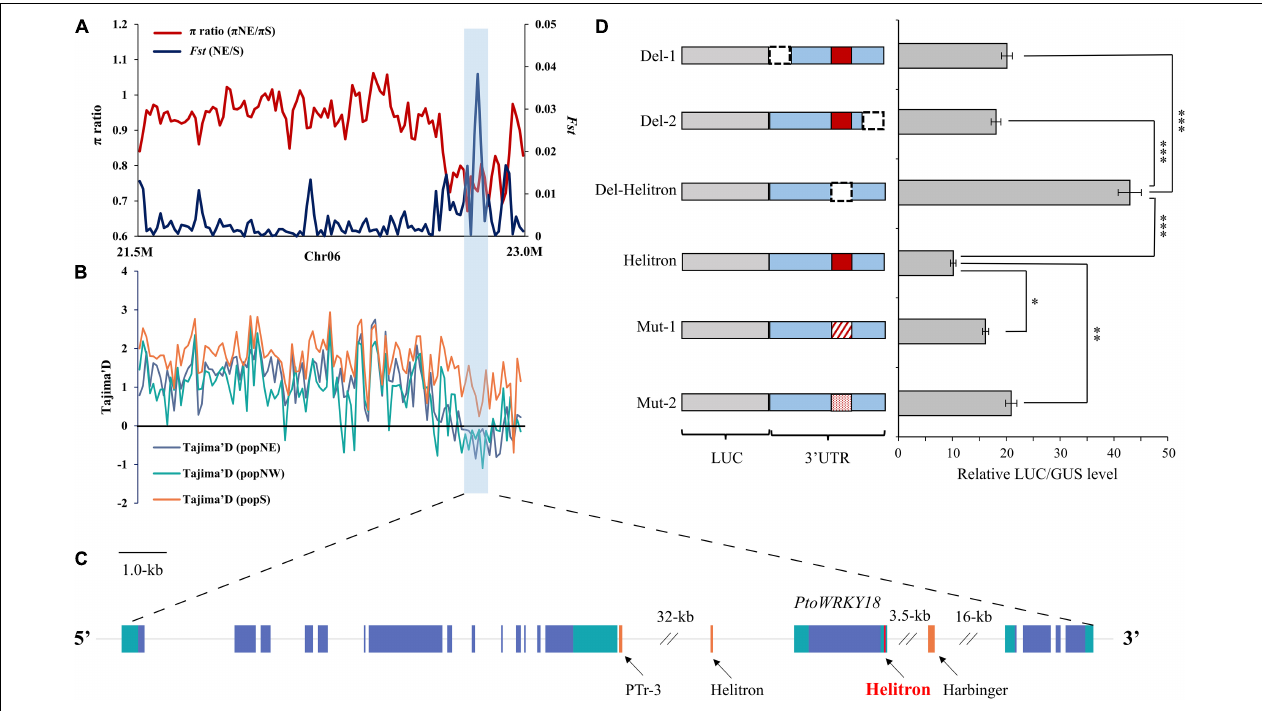
FIGURE 5 | An adaptive TE within selection regions among the three P. tomentosa natural climatic regions. (A–C) Adaptive TEs with a selection signal between each pairwise comparison. The values of F st , π , and Tajima’s D were plotted using a sliding window of 500-bp. Target population (Orange), and reference population (blue). The horizontal dotted line represents the corresponding average value in all selected scanning areas. Genes at the bottom (blue rectangle, coding sequences; black line, introns and intergenic regions; green rectangle, 5 (cid:48) and 3 (cid:48) untranslated regions; red rectangle, Helitron insertion TEs; orange rectangle, other TEs). (D) Left panel, firefly luciferase reporter constructs fusing the full-length WRKY18 3 (cid:48) -UTR (Helitron), deletion variants (Del-1, Del-2, and Del-Helitron), and substitute variants (Mut-1, and Mut-2). Luciferase gene was dark gray with diagonal; 3 (cid:48) UTR is blue, the deleted area is represented by dotted line, and the variant is represented by red line with diagonal and point; The red rectangle in the 3 (cid:48) UTR represents the Helitron transposon. Right panel, relative luminous units and transcription levels quantified by qPCR (Helitron normalized to 1). The data in the right panel represent the mean ± standard deviation, n = 3. The *, ** and *** indicate significant difference at P < 0.05, P < 0.01, and P < 0.001, respectively (Student’s t -test). The data show the relative LUC/GUS level calculated by three independent replications.